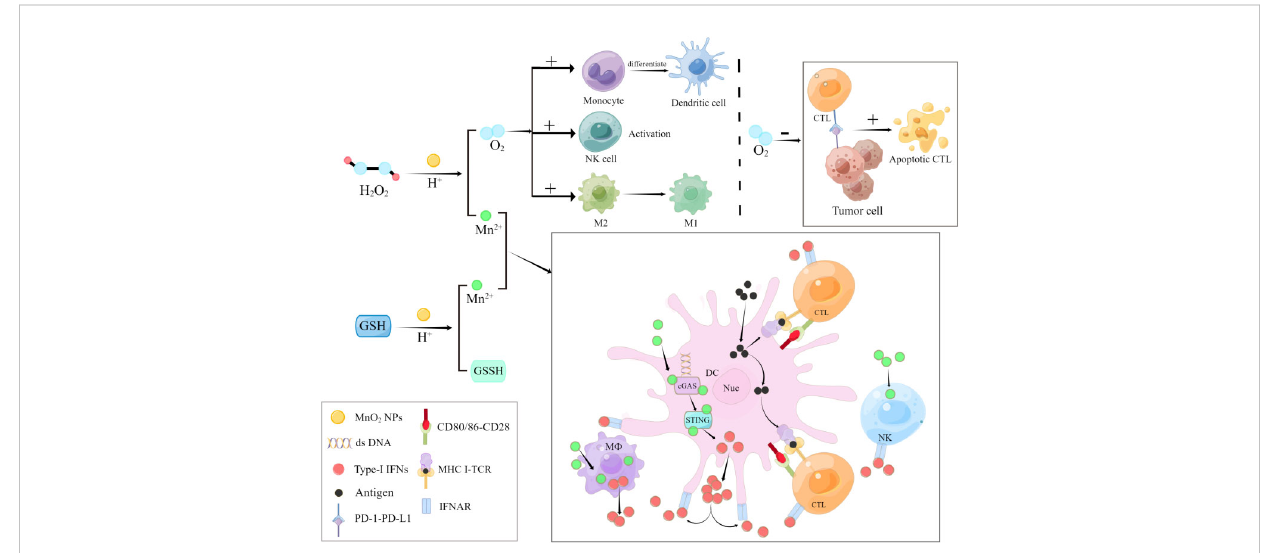
FIGURE 3 MnO 2 NPs regulate innate and adaptive immune cells against tumor and